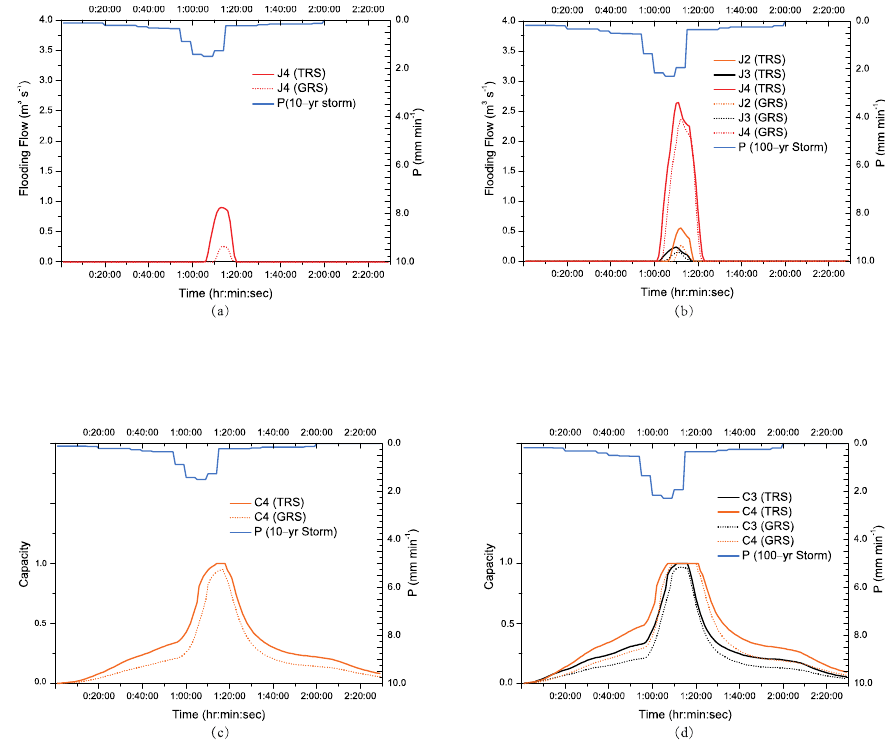
Figure 7. Comparison of hydraulic conditions between TRS and GRS for 2 single precipitation events (10-yr, and 100-yr). ( a ) the flooding nodes (10-yr precipitation); ( b ) the flooding nodes (100-yr precipitation); ( c ) the overloaded conduits (10-yr precipitation); ( d ) the overloaded conduits (100-yr precipitation).